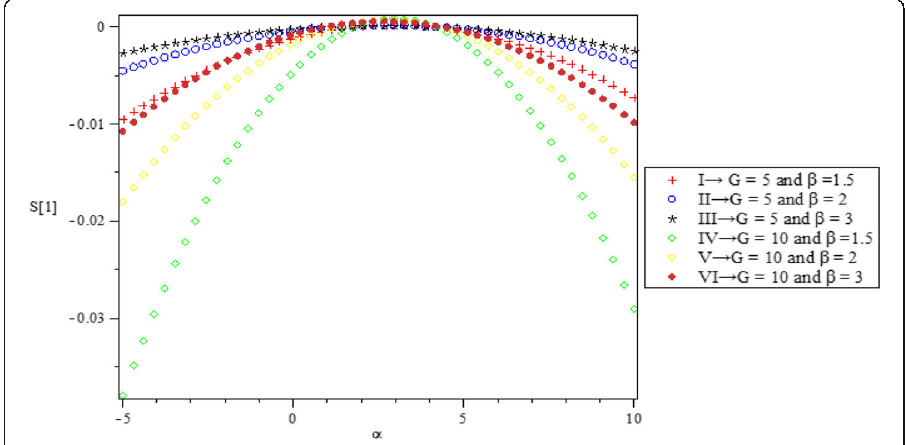
Fig. 30 First-order skin friction (S[1] profile, r = − 1, ϵ = 0.25, P = 0.71, λ = 0.01, and y =